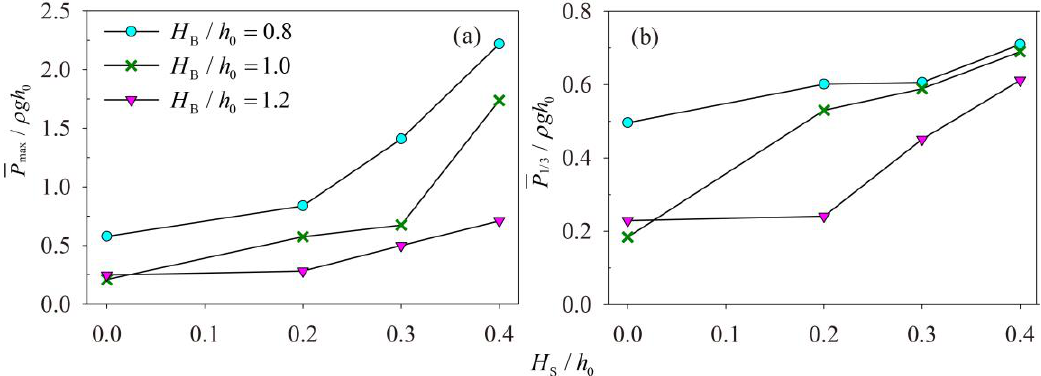
Figure 11. Variation trends of impact pressure with different gap sizes ( T = 1.91 s, ω / ω 0 = 1.004). ( a ) P max ; ( b ) P 1/3 .